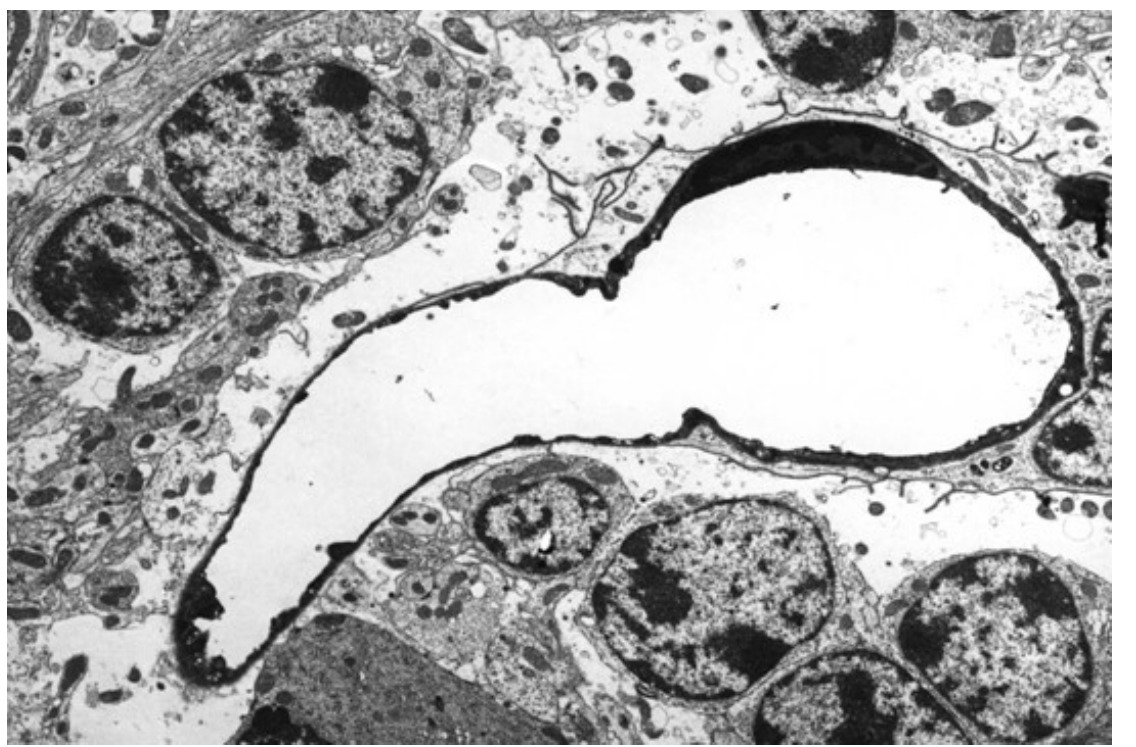
Figure 2. Transmission electron micrograph of a capillary in an acutely ETX-intoxicated ovine brain showing marked endothelial attenuation and electron density (coagulation necrosis) with nuclear pyknosis. Uranyl acetate and lead citrate. Reproduced from Uzal et al., 2016.